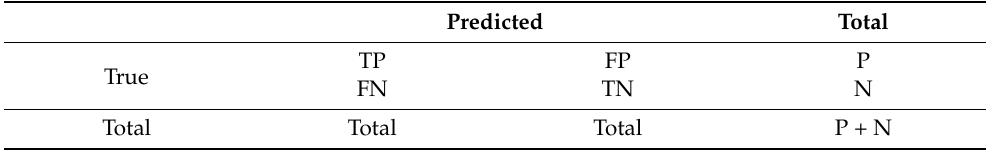
Table 3. Confusion matrices for two tested classes. Predicted Total